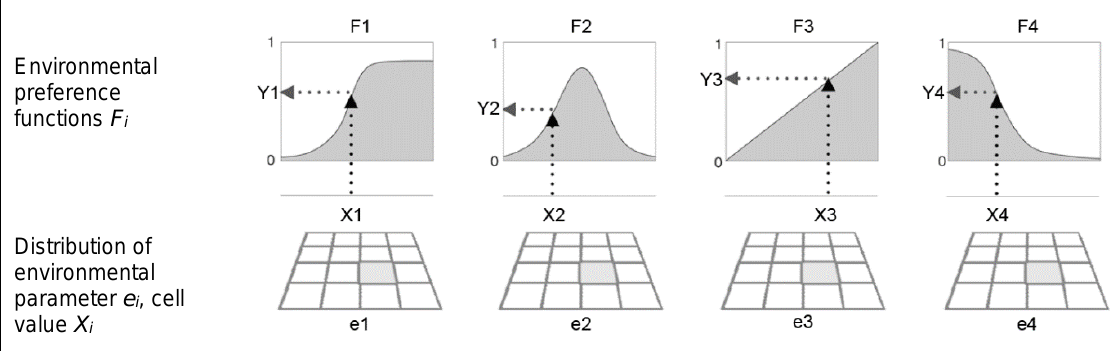
Fig. 1. Schematic diagram of the environmental capacity calculations with 4 hypothetical environmental preference functions. Environmental suitability Y for environmental driver e is obtained by looking up cell value X along environmental preference function F . The total environmental suitability for a cell is then defined as Y 1 · Y 2 · Y 3 · Y 4 (adapted from Christensen et al.